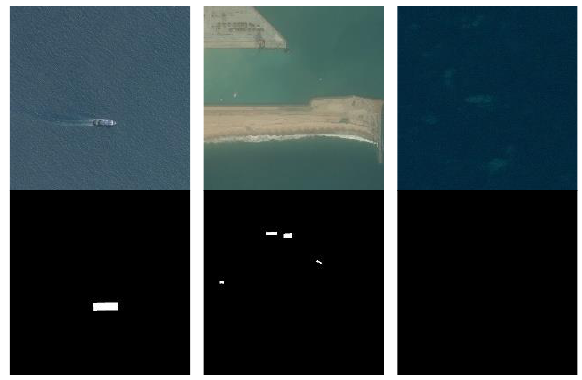
Figure 2. Dataset Kaggle “Airbus Ship Detection”